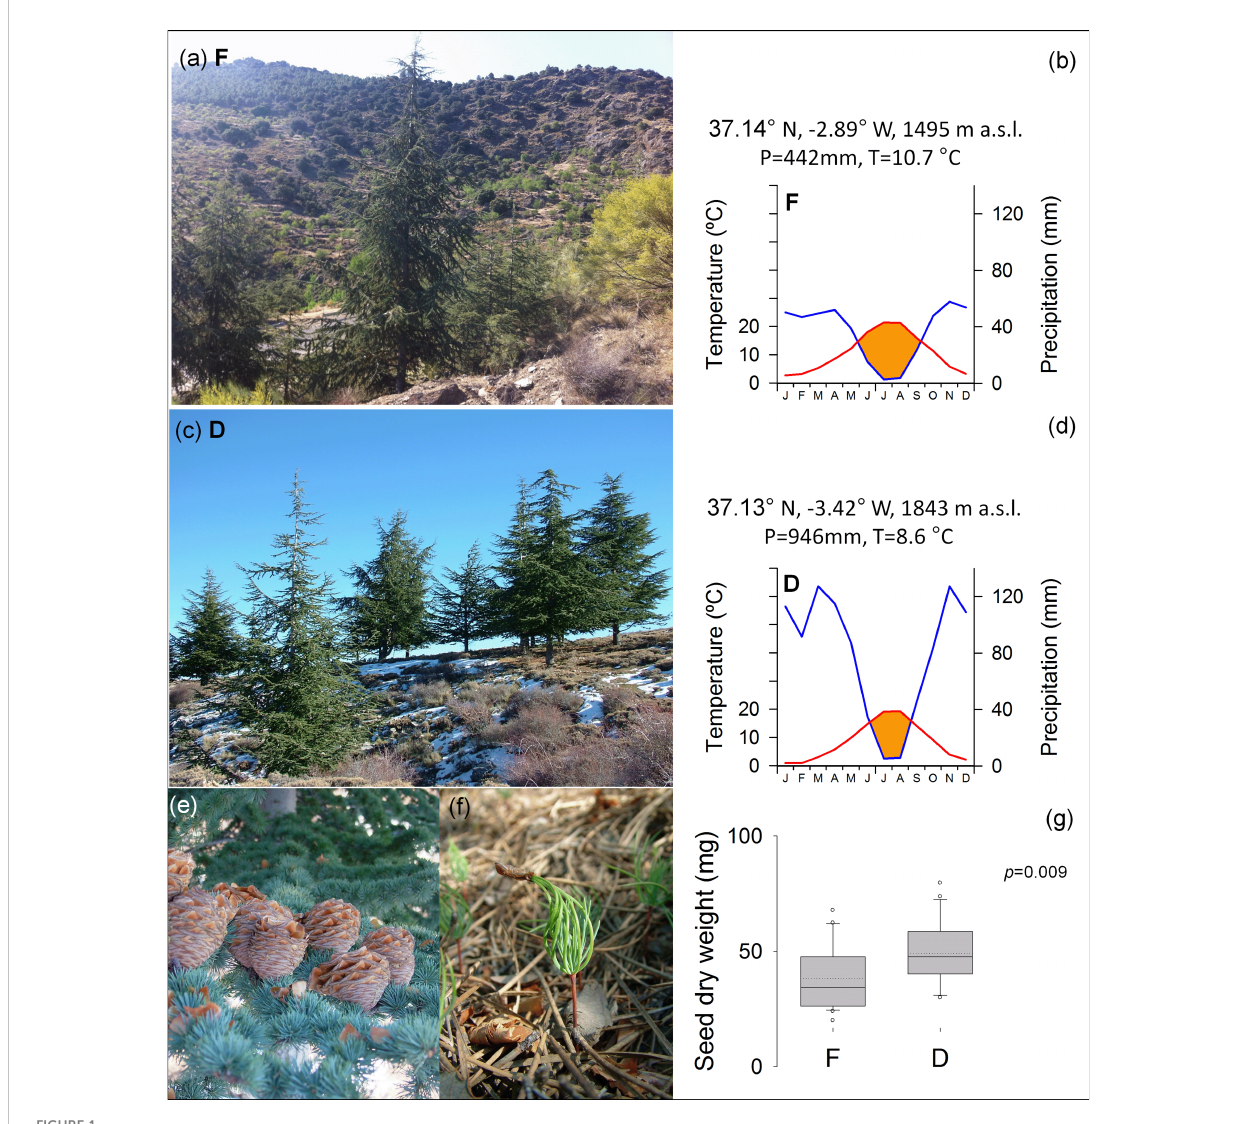
FIGURE 1 Atlas cedar ( Cedrus atlantica ) trees at Fiñana, F (A) and Dornajo, D (C) sites (Sierra Nevada range, south Spain). Sampling location (latitude N, longitude W, and elevation m a.s.l.) and mean climate for the period 1971-2021 are indicated for F (B) and D (D) sites, respectively. The blue lines indicate the monthly total precipitation, the red lines indicate the monthly mean temperature, the shaded orange area indicates the water de fi cit period; total annual precipitation (P, mm) and mean annual temperature (T, °C) are also noted. Mature cones with spreading seeds (E) and germinating seedlings (F) were highly viable in both sites. Mean seed dry weight (G) ; the inset indicates the p value for